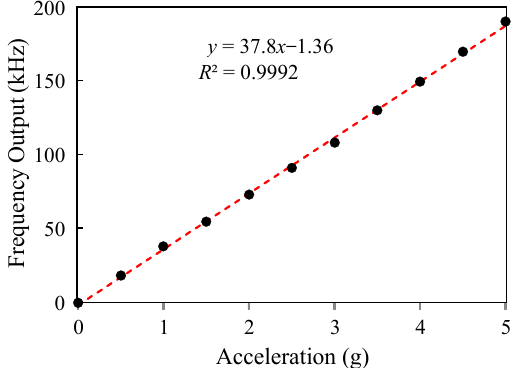
Figure 13. Dynamic acceleration test. Table 2. Performance comparison of monolithic CMOS accelerometers.